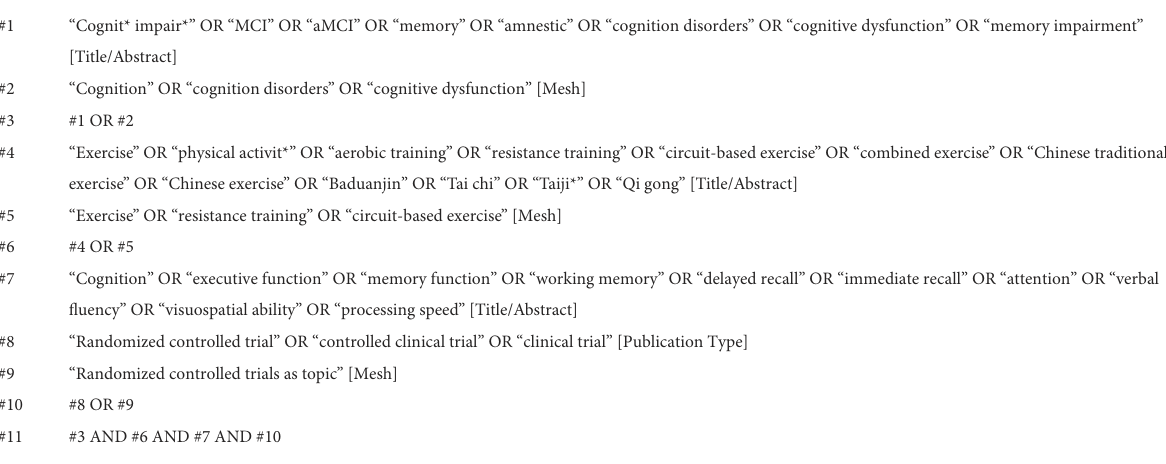
TABLE 1 Search strategy in